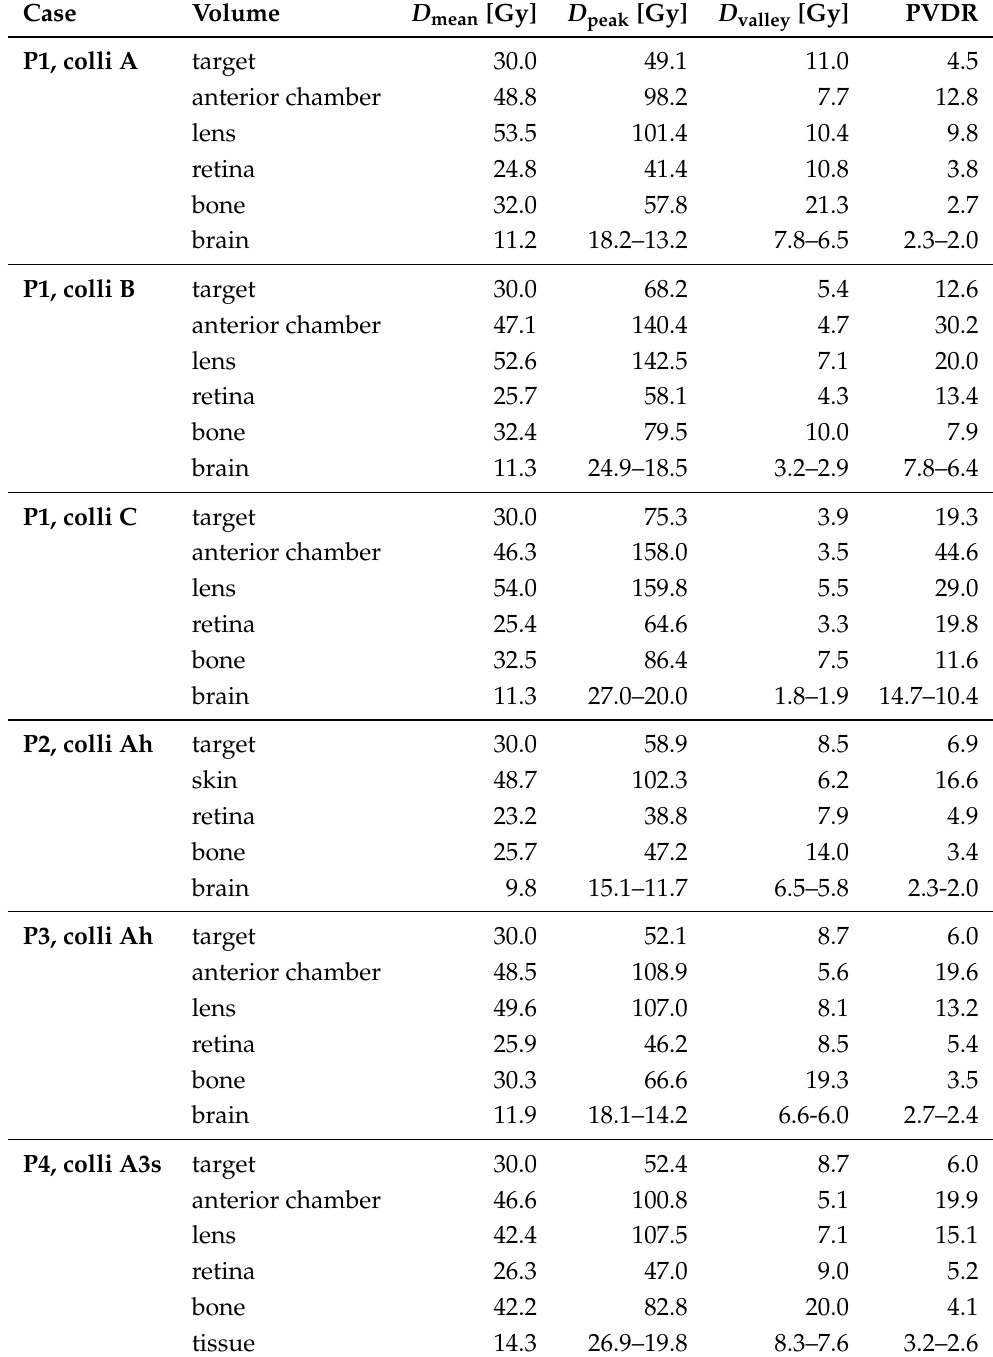
Table 5. Mean, peak and valley doses in the ROI for the different irradiation cases, assuming a prescription target dose of D mean = 30